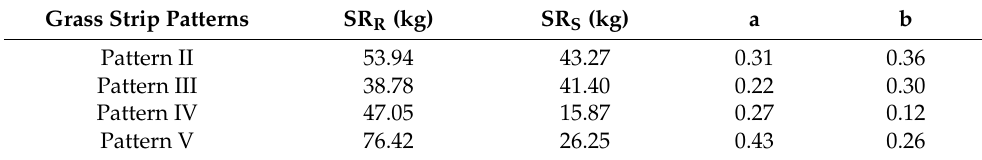
Table 2. SR R , SR R , and their corresponding efficiency coefficients for different grass strip